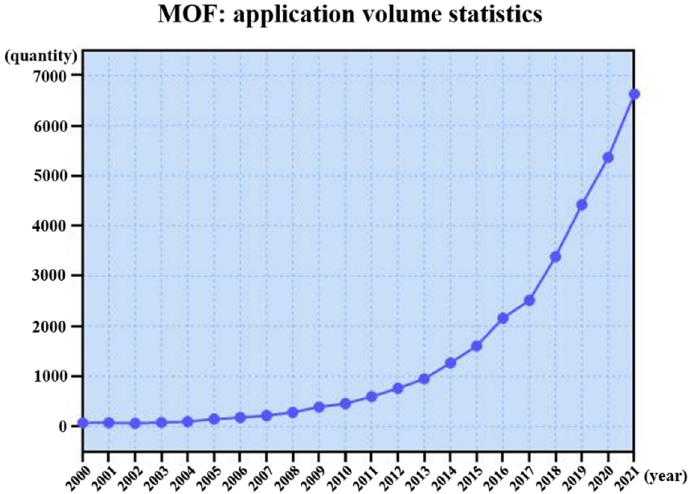
Figure 15. The research quantity curve of MOF in the past two decades.